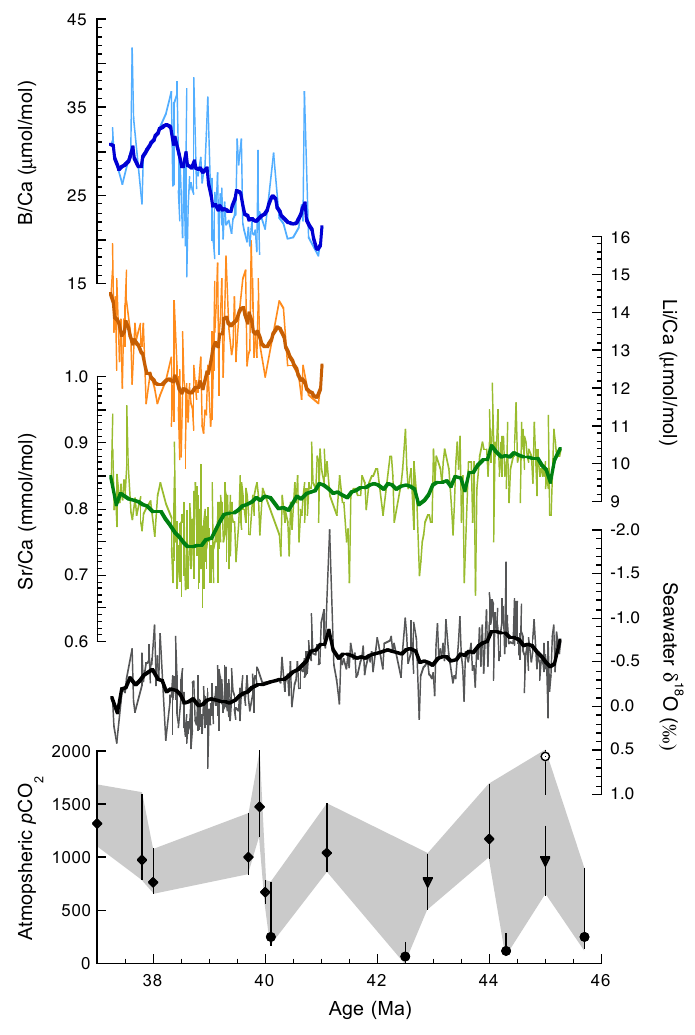
Fig. 3. Comparison of the downcore O. umbonatus X/Ca records with the seawater δ 18 O reconstruction from ODP Site 1209 (Dawber and Tripati, 2011). Shown for reference are estimates of atmospheric p CO 2 based on alkenones (diamonds, Pagani et al., 2005; Freeman and Hayes, 1992); boron isotopes in carbonates (circles, Demicco et al., 2003); stomatal indices (inverted triangle, McElwain, 1998; Kurschner et al., 2001); and paleosol carbon isotopes (open circle with dot, Ekart et al.,